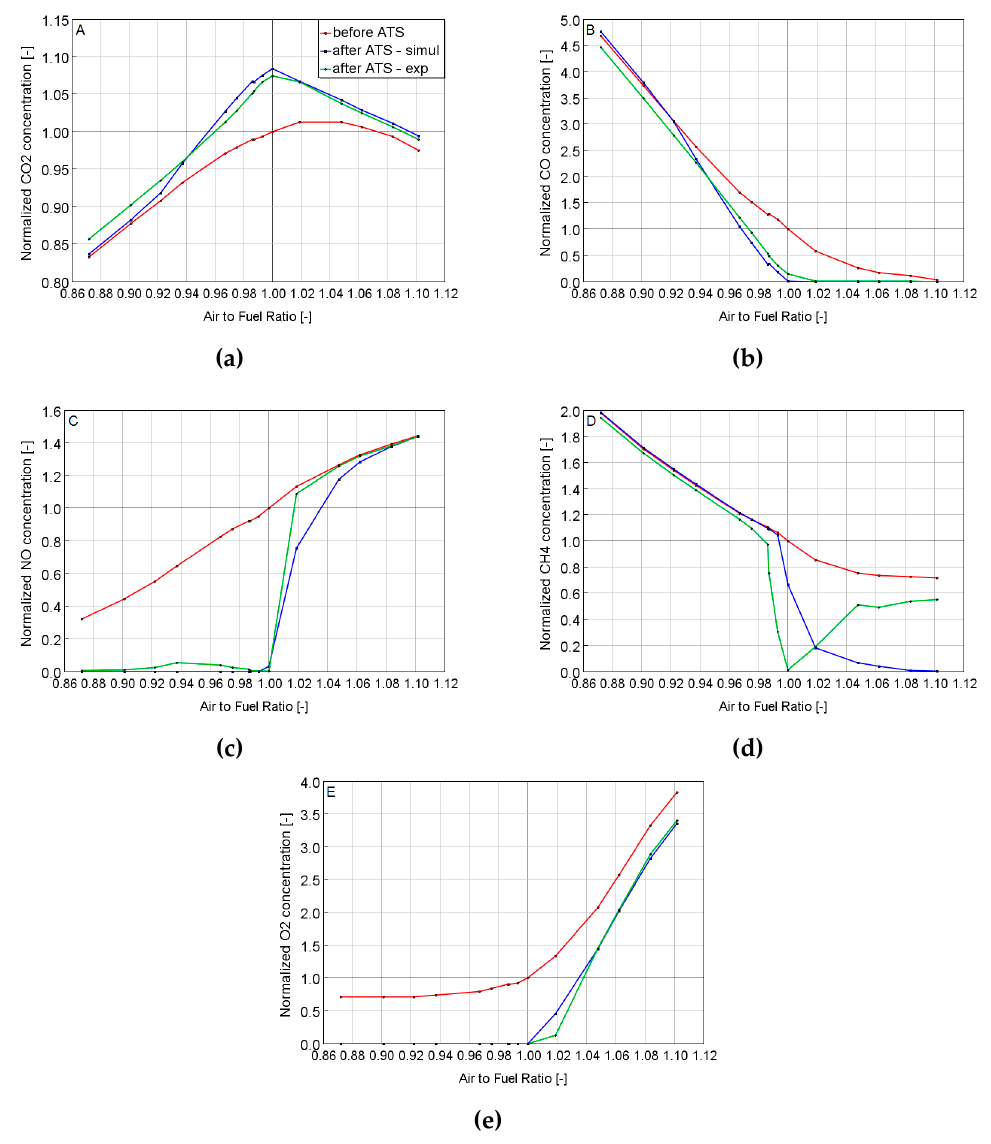
Figure 8. SS tests at 40% Load. Gas Temp. ≈ 620 ◦ C. (1900 RPM, 40% load). ( a ) Num / Exp. CO 2 engine out and tailpipe concentration. ( b ) Num / Exp. CO engine out and tailpipe concentration. ( c ) Num / Exp. NO engine out and tailpipe concentration ( d ) Num / Exp. CH 4 engine out and tailpipe concentration. ( e ) Num / Exp. O 2 engine out and tailpipe concentration.